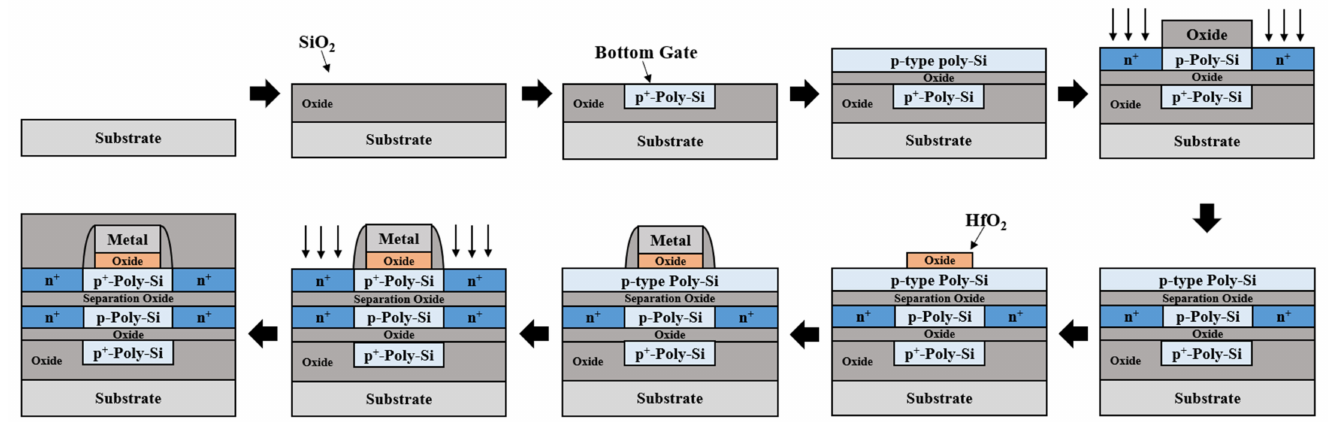
Figure 2. Key fabrication steps of the proposed 1T-DRAM crystallized via excimer laser crystalliza- tion